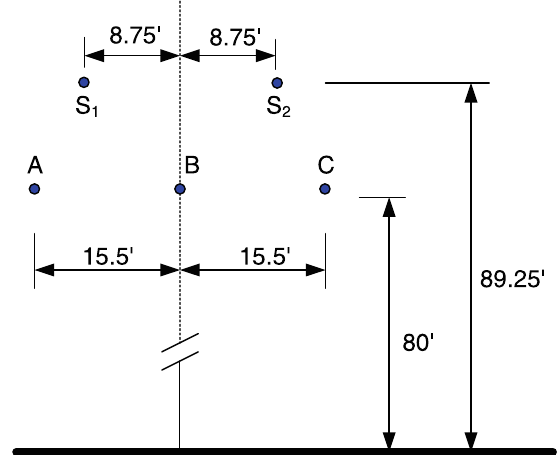
Fig. 6 Tower configuration of an actual 69-kV transmission line model used for demonstrating the proposed